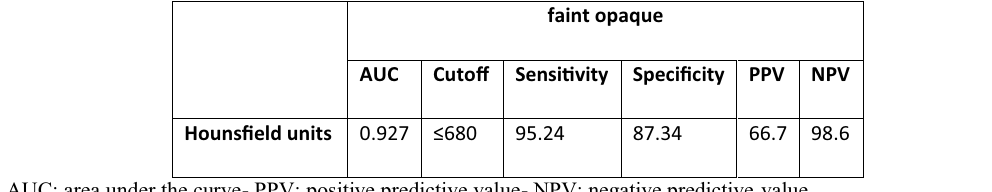
Fig. 3 ROC curve of faint opacity in plain PKUB about the density of the stones in Hounsfield